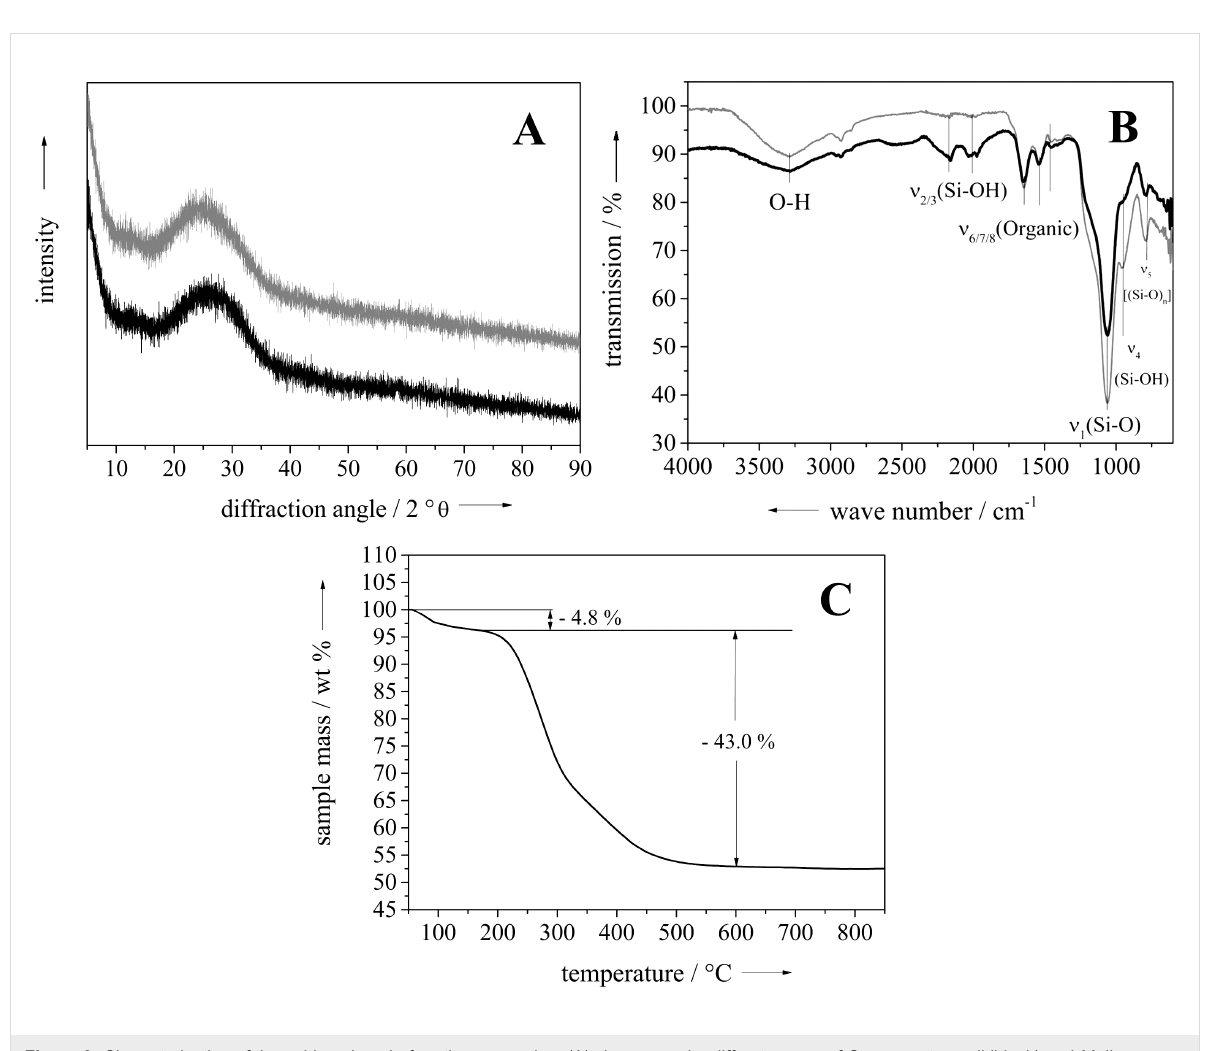
Figure 3: Characterization of the golden algae before the conversion. (A) shows powder diffractograms of Synura petersenii (black) and Mallomonas caudata (grey), (B) shows IR spectra of Synura petersenii (black) and Mallomonas caudata (grey), and (C) shows a thermogravimetric analysis of Synura petersenii in dynamic air